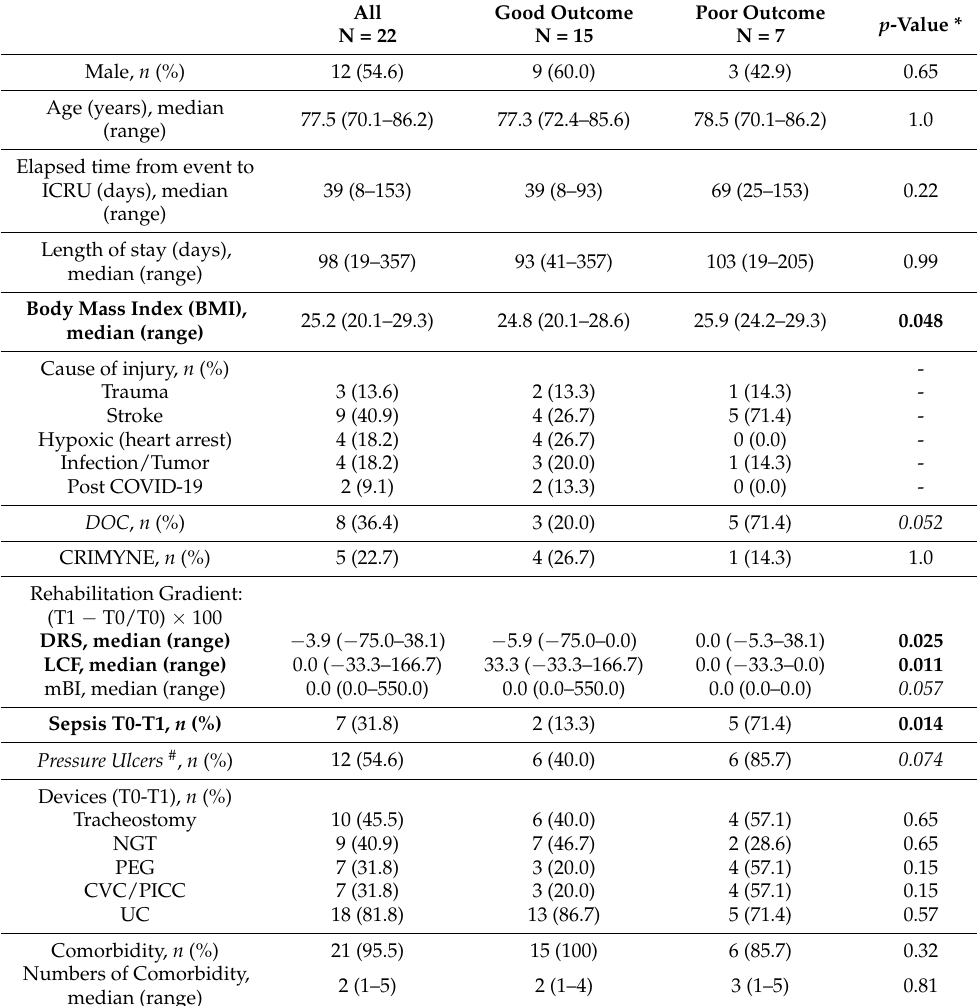
Table 2. Results of the analyzed variables at T1 assessment (N = 22). In bold are the significant factors and their p -values. In italics are the factors and their p -values that resulted in close-to-threshold levels of significance at statistical analysis ( p <